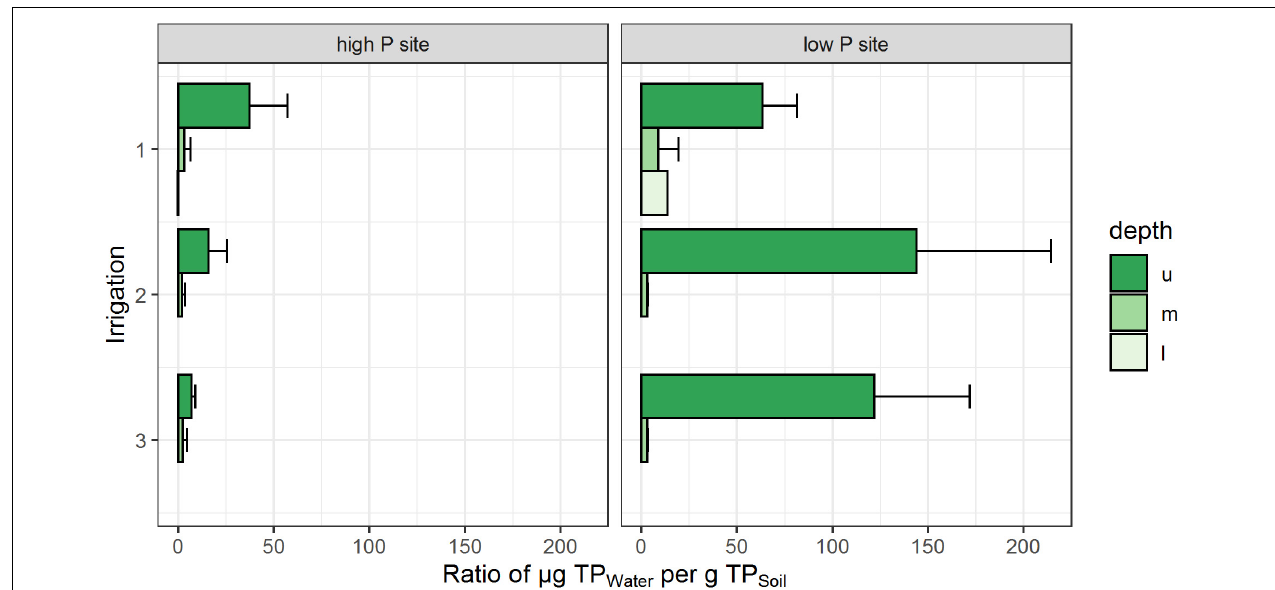
FIGURE 5 | Cumulative total P loads in relation to soil P stock of each site. Depth refers to the respective lysimeter installation depths (u – upper, m – middle, l – lower). Ratios represent the arithmetic means of three replicates per site. No bar indicates no samples from the respective depth and irrigation. Error bars represent the standard deviation of the